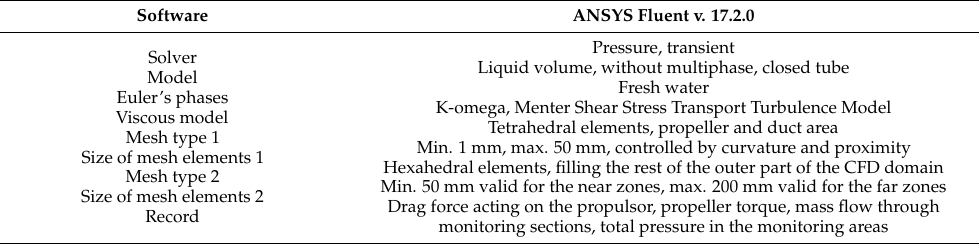
Table 3. Set CFD system and calculation domain